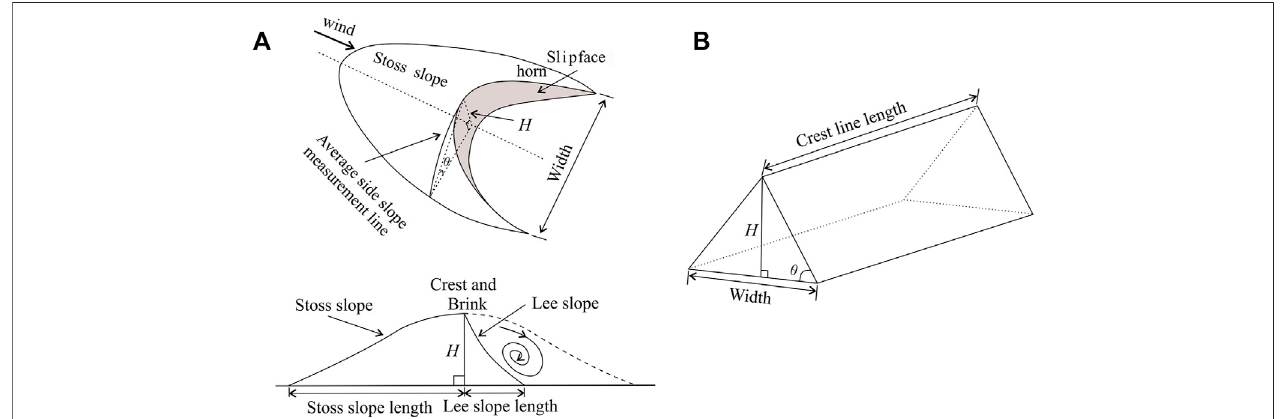
FIGURE2| Schematicdiagramofthe (A) barchansand (B) lineardunes,andtheirmajormorphologicalparameters. H ,heightofthedune ’ screstabovethebed, θ , the average angle of one side slope of the dune with respect to the surface. Source: (A) modi fi ed after Hesp and Hastings (1998).